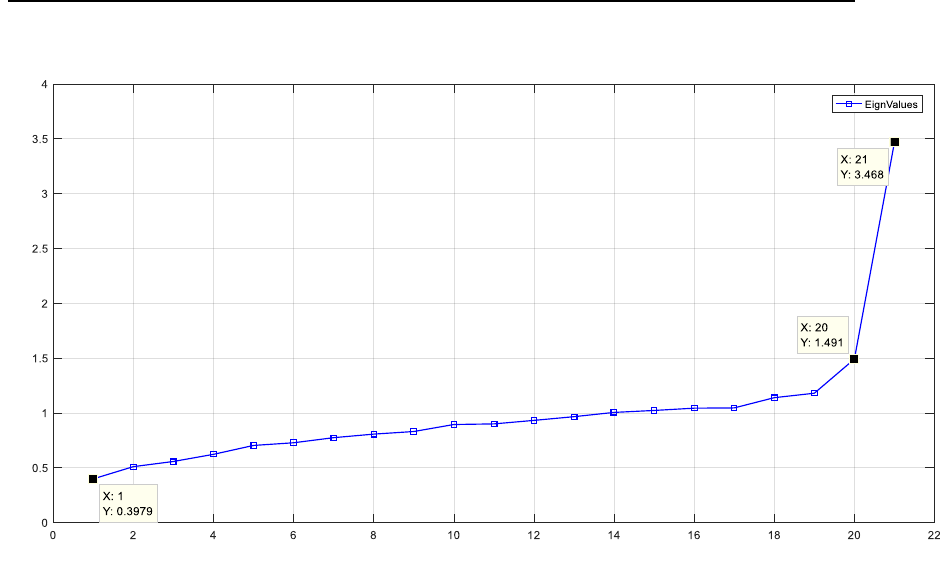
Figure 3. The eigenvalues of the correlation matrix are shown. That is obvious that the largest eigenvalue is 2.5 times of the previous eigenvalue, indicating that this eigenvalue contains market information.